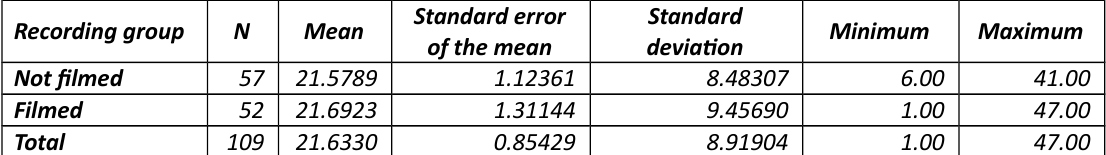
Table 3. Results of the Trait